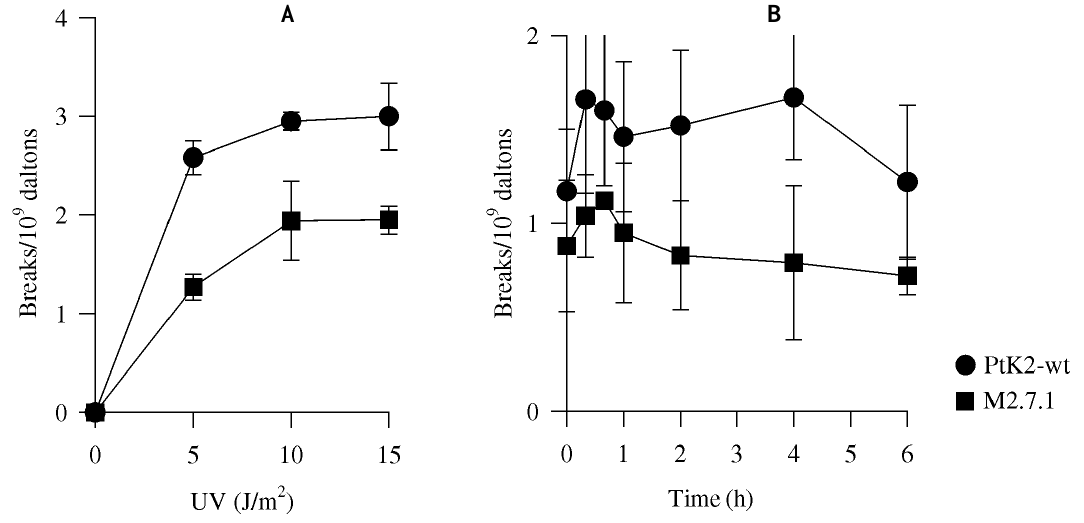
Figure 3 - DNA repair measurements by incision assay. A : UV dose response. PtK2 (circles) and M2.7.1 (squares) cells labeled with 3 H-thymidine were incubated for 40 min with HU and araC, irradiated with indicated UV doses, incubated with inhibitors for another 40 min and then prepared for HAP chromatography. B : PtK2 (circles) and M2.7.1 (squares) cells labeled with 3 H-thymidine were irradiated with UV (5 J/m 2 ), incubated in fresh medium for indicated time before incubation for 40 min with HU and araC and then prepared for HAP chromatography. wt, Wild-type